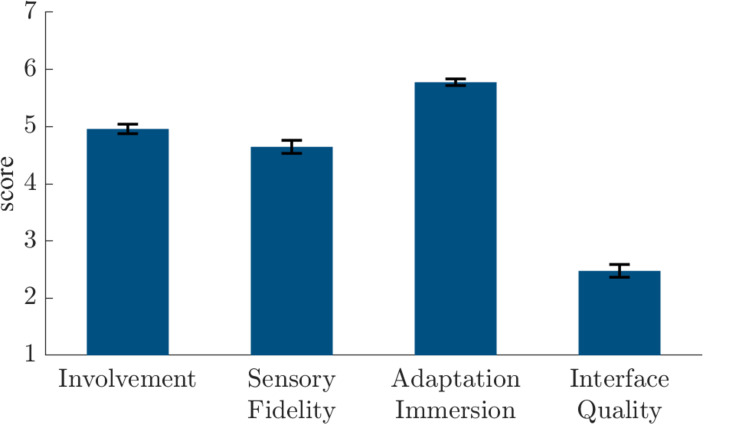
Presence Questionnaire 3 (Witmer et al., 2005) scores in the experiment.